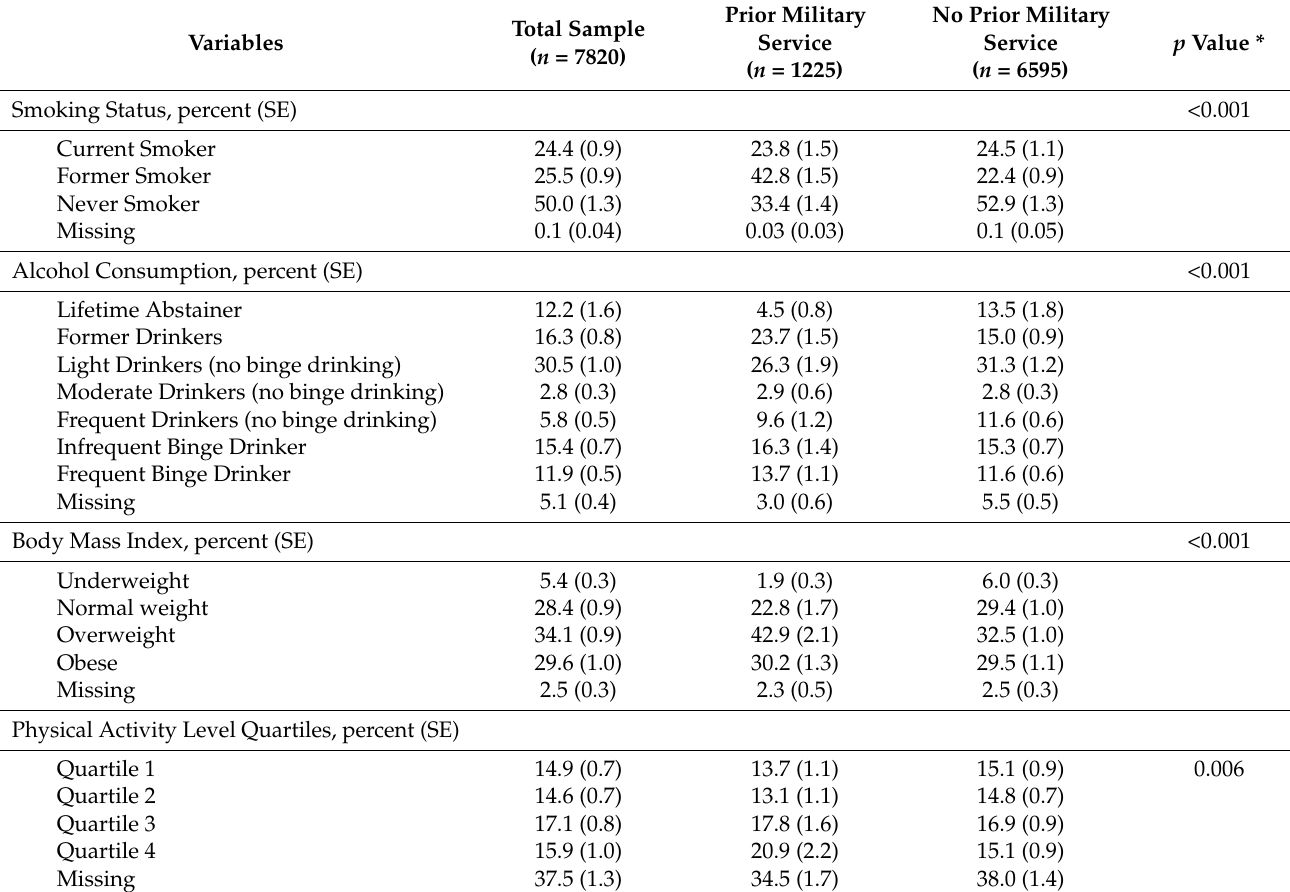
Table 2. Weighted behavioral and anthropometric characteristics ( n = 7820).